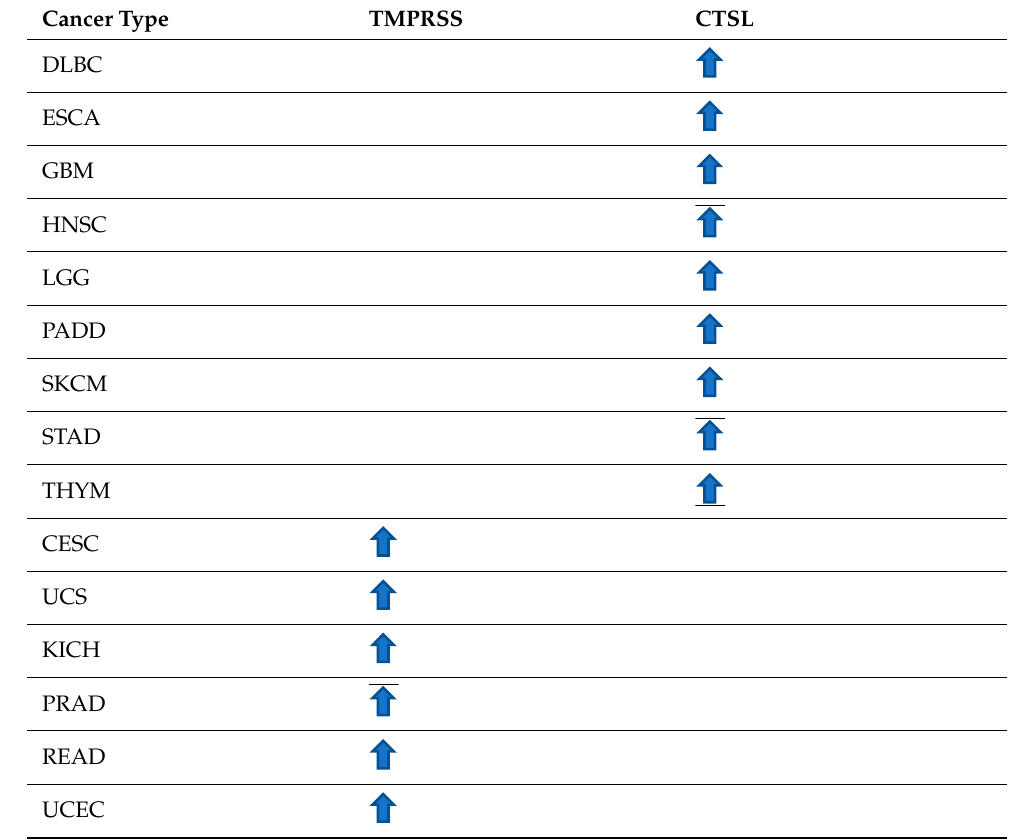
Table 1. The differential expression of key enzymes essential for viral spike proteins interaction in different cancer types.